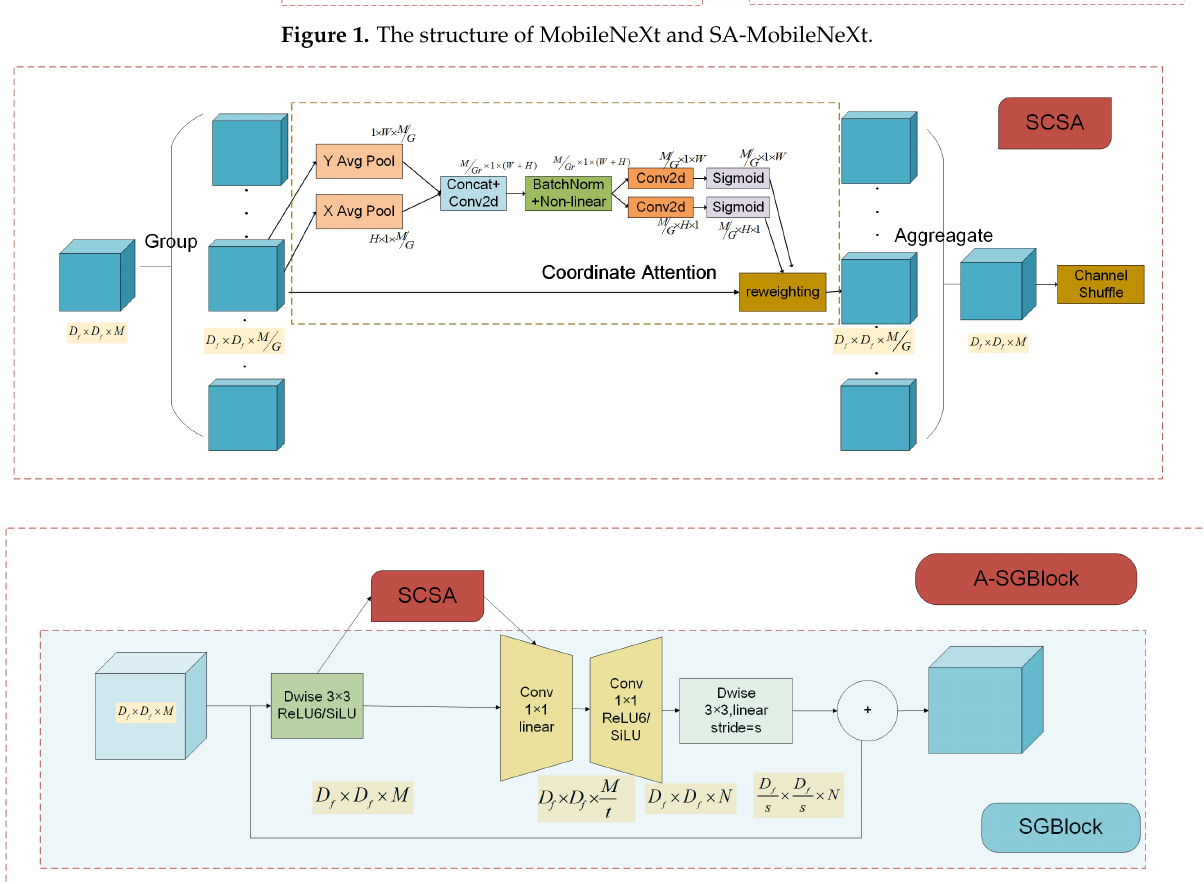
Figure 1. The structure of MobileNeXt and SA-MobileNeXt.